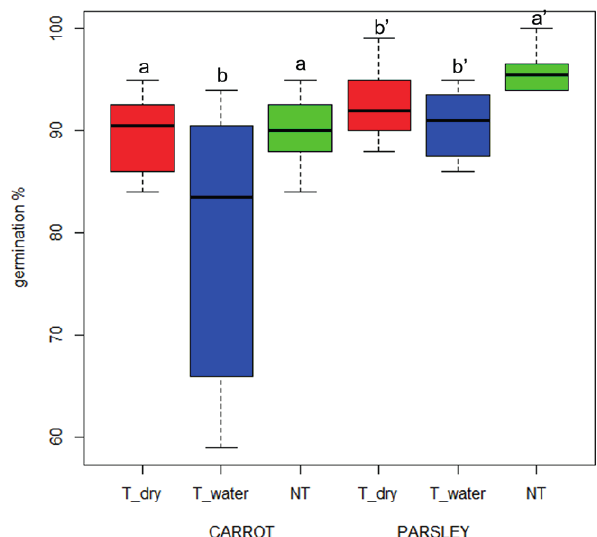
Figure 1. Mean germination rates (%) for carrot and parsley seeds after different treatments. Left: rates for dry heat-treated (T_dry), water heat-treated (T_water) and untreated (NT) carrot seed lots. Means and standard deviations were calculated for n = 2000 seeds from five seed lots. Right: germination rates for dry heat-treated (T_dry), water heat-treated (T_water) and untreated (NT) groups of parsley seed lots. Means and standard deviations were calculated for n = 800 seeds from two seed lots. Statistical significance of differ- ences was determined using Chi-square post-hoc multiple compari- son tests: different letters indicate significantly different